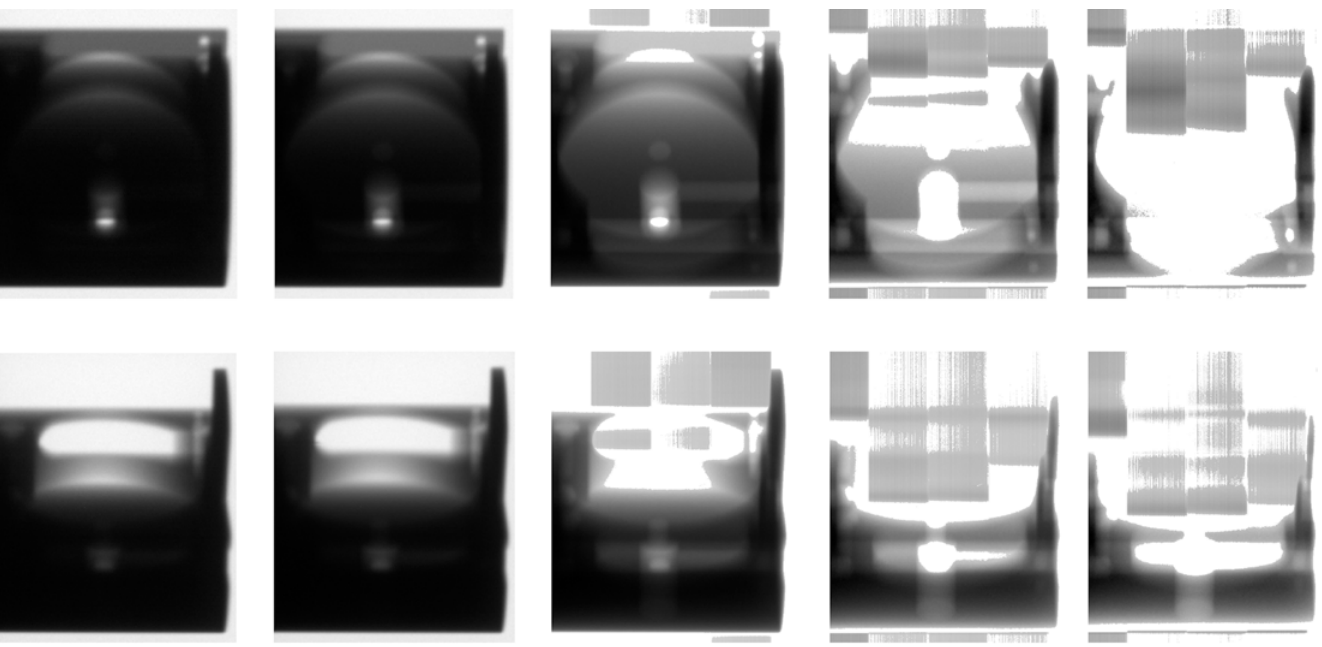
Fig 3. The image sequences collected at varying energies. Each row corresponds to a different projection angle (0° and 90°), and each column corresponds to a different transillumination voltage (60 kV, 70 kV, 80 kV, 90 kV, and 100 kV).